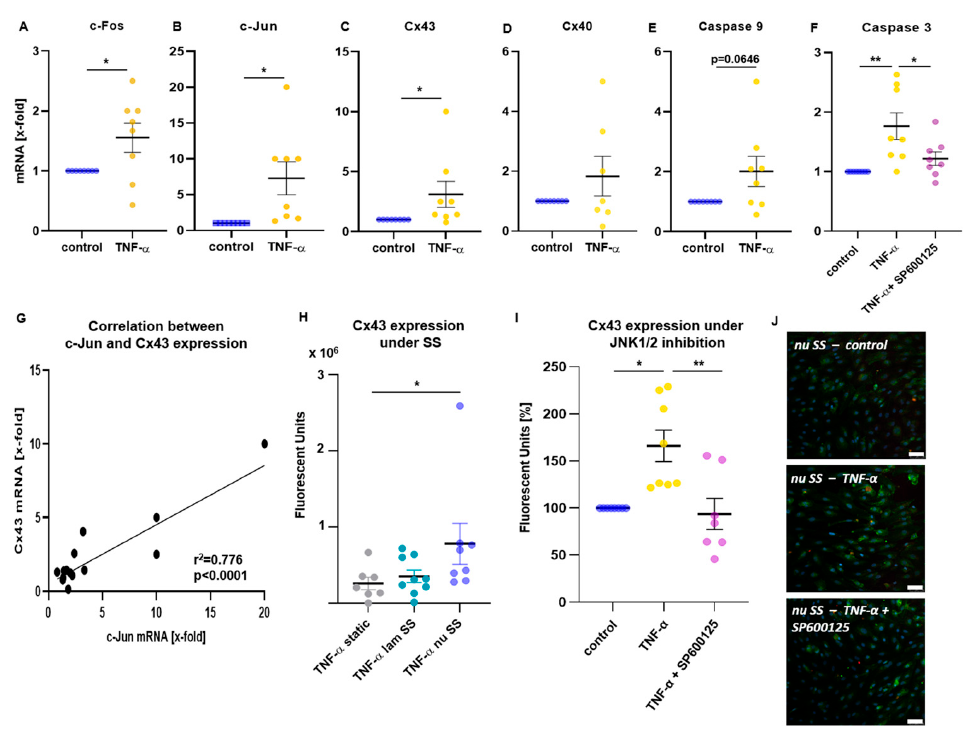
Figure 2. JNK activation in inflammatory- and mechano-stimulated ECs is associated with the induction of Cx43 and proapoptotic caspases. ( A – F ) HUVECs were seeded into bifurcation flow- through cell culture slides, creating regions of laminar and non-uniform SS. Cells were exposed to SS by application of flow for 20 h. For the last 2 h, cells were stimulated with TNF- α with or without addition of JNK1/2 inhibitor SP600125. Flow was stopped and RNA was isolated from HUVECs and reverse transcribed into cDNA to perform RT-qPCR. Transcription levels are illustrated as x-fold mRNA compared with control treatment, which was set to 100%. Under SS conditions, TNF- α induced expression of JNK-associated transcription factors ( A , B ), of gap junction protein Cx43 ( C ) and the proapoptotic proteases caspase 9 ( E ) and caspase 3 ( F ), the latest was suppressed by JNK1/2 inhibition. No significant changes were observed for Cx40 ( D ). Data are presented as mean ± SEM, n = 8, analyzed by unpaired t-test ( A – E ) or one-way ANOVA followed by Tukey’s multiple comparison ( F ). ( G ) Linear regression analyses show a correlation of c-Jun and Cx43 tran- scription levels. n = 15 ( H – J ) Flow experiments were performed as described and protein expression of Cx43 was quantified using immunofluorescence. ( H ) Cx43 protein expression was higher in TNF- α treated HUVECs exposed to non-uniform SS compared to static conditions. ( I ) Increase in Cx43 pro- tein expression in non-uniform SS-exposed HUVECs following TNF- α stimulation was suppressed by JNK1/2 inhibition. Data are presented as mean ± SEM, dots represent values from individual experiments, n = 7–9, analyzed by Kruskal–Wallis test followed by Dunn’s multiple comparison. ( J ) Exemplary microscopic images of Cx43 expression under non-uniform SS are shown (DAPI = blue, Cx43 = green, Cx40 = red; bar represents 50 µ m). * p < 0.05, ** p <